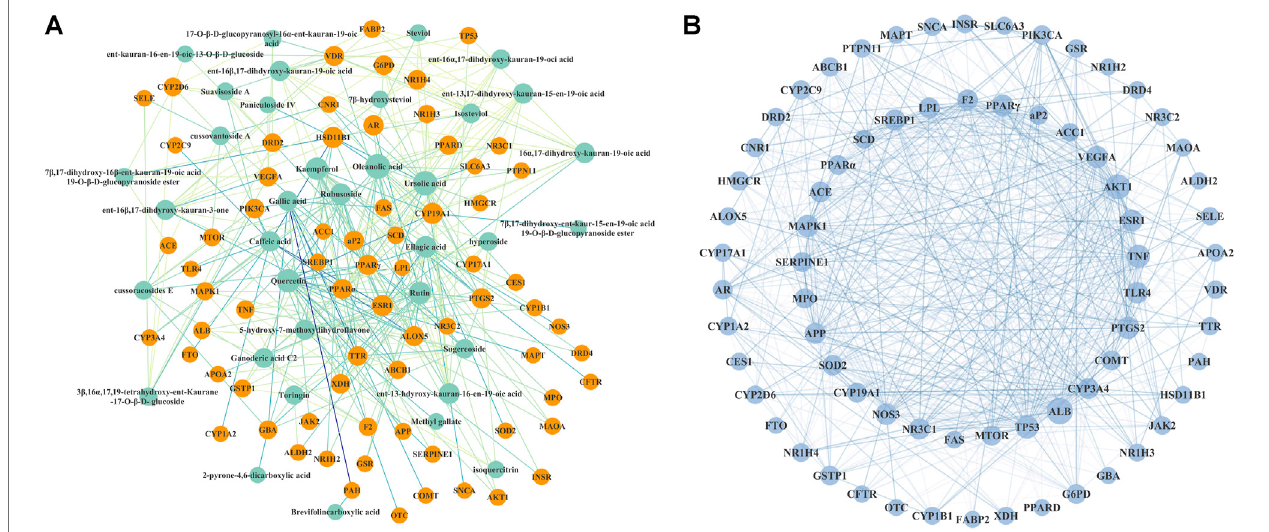
FIGURE 2 | Interaction network of Rubus chingii var. suavissimus on lipid metabolism disorder. (A) Bioactive compound – therapeutic target network. 36 green nodesrepresentbioactivecompoundsinRS,and71orangenodesrepresentthelipidmetabolismdisorder-relatedtargetsofRS. (B) Protein – proteininteractionnetwork of the picked 71 target